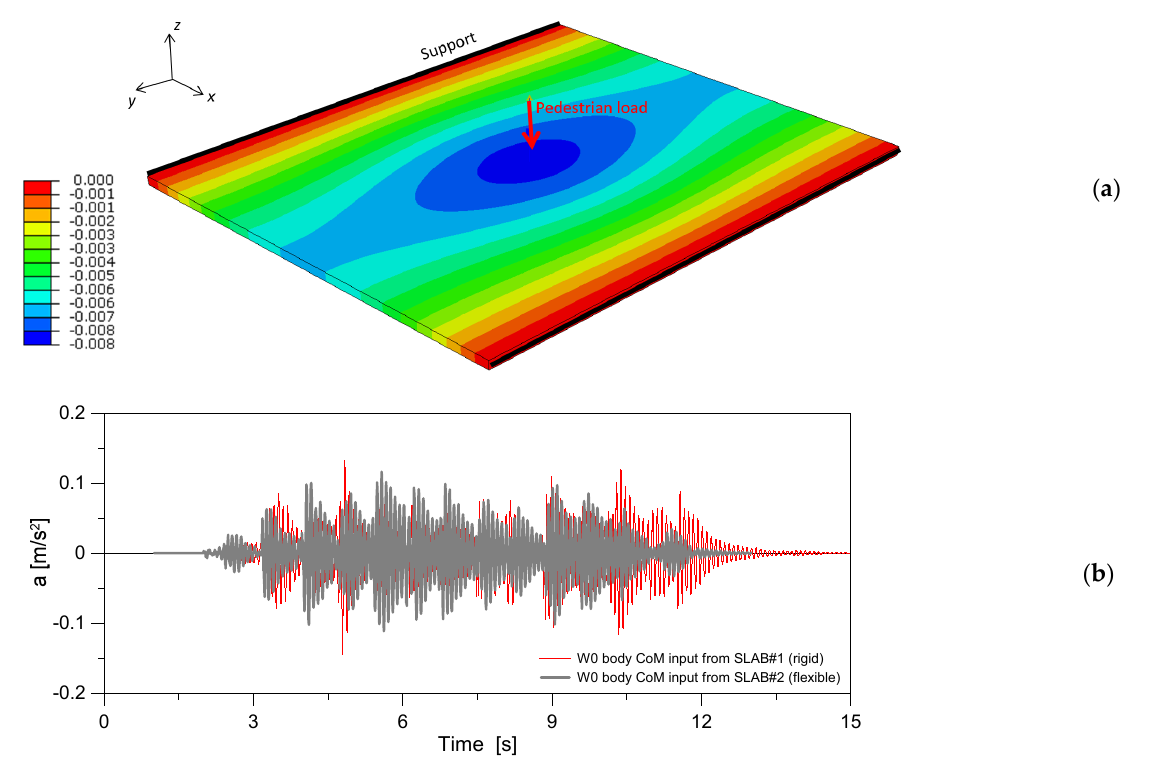
Figure 17. Loading protocol: ( a ) input body CoM acceleration and ( b ) sine curve fit of an experimental stride record (signal #7, W1) to derive a synthetized signal.